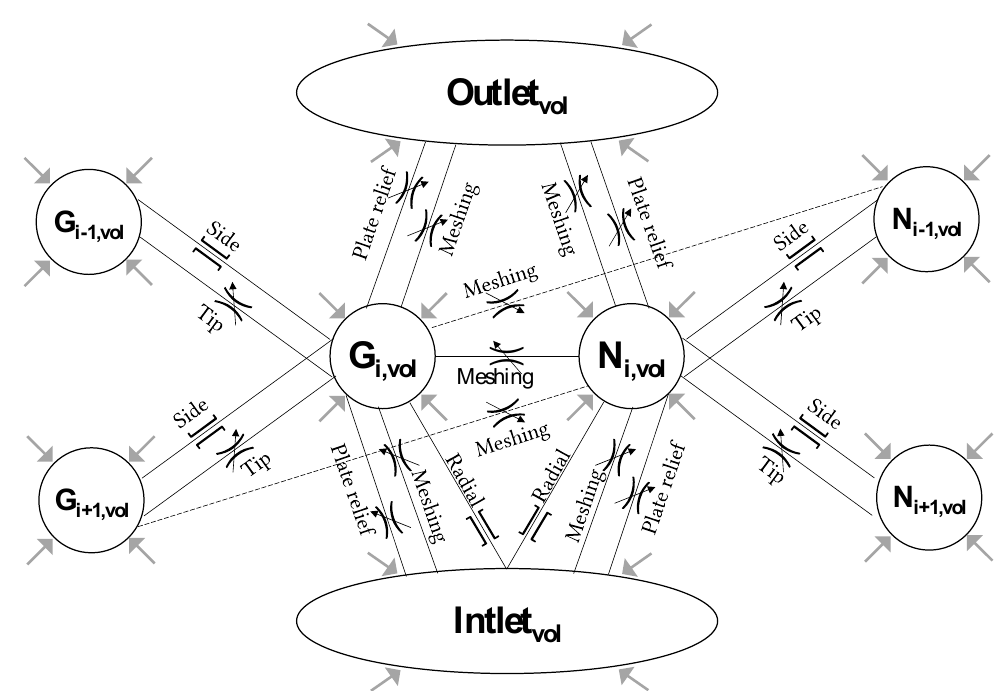
Figure 5 . Overview of the lumped parameter model . Figure 5. Overview of the lumped parameter